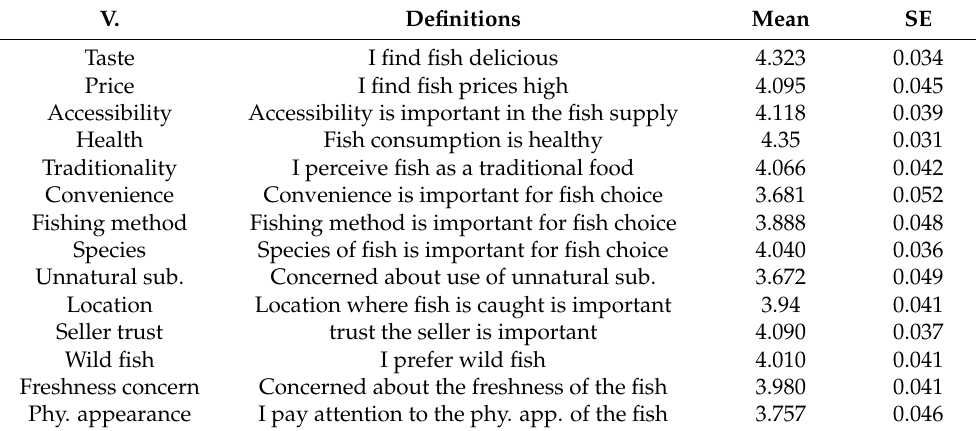
Table 4. Descriptive statistics on fish choices.